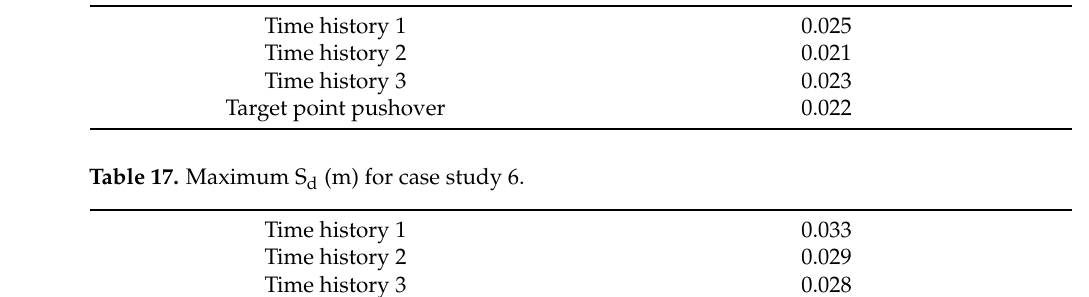
Table 16. Maximum S d (m) for case study 5. Table 17. Maximum S (m) for case study 6. d